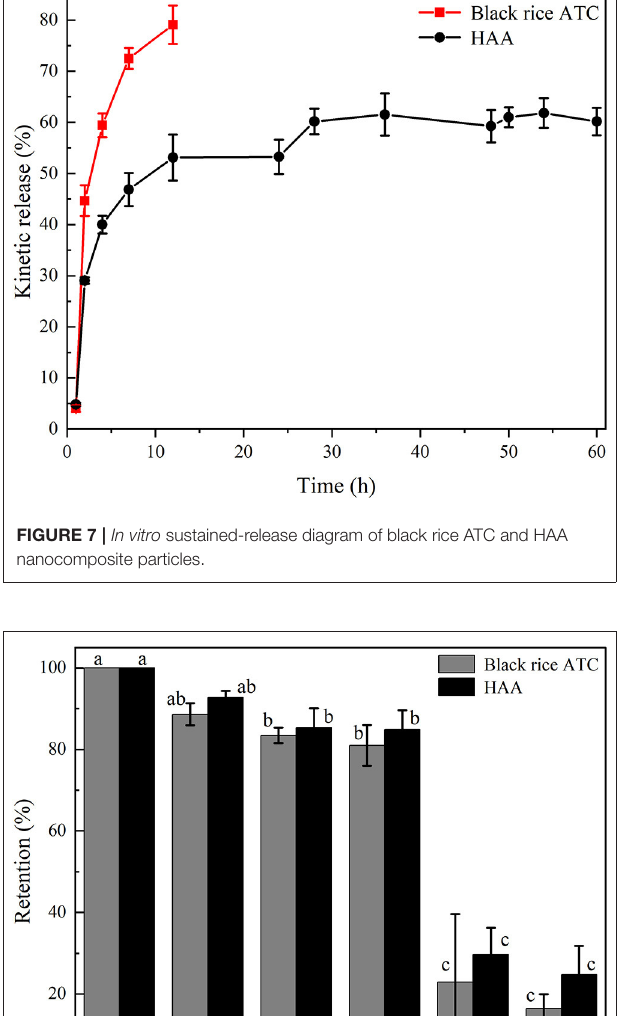
XO. When HAA nanocomposite particles were used as inhibitors to inhibit XO activity, the inhibitory rate of HAA nanocomposite particles (2.0 mg/mL) on XO activity in vitro reached 56.42%, the inhibitory effect improved with increasing concentration.